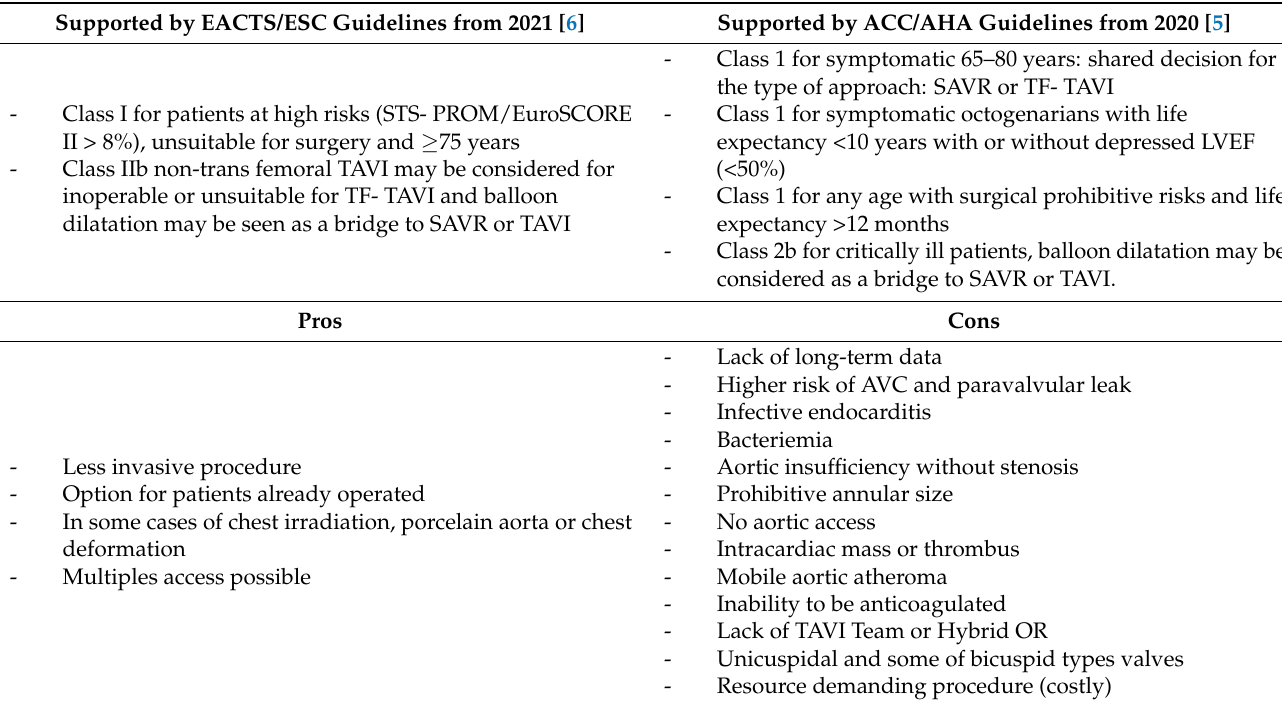
Table 7. Decision Making Algorithm. TAVI for older